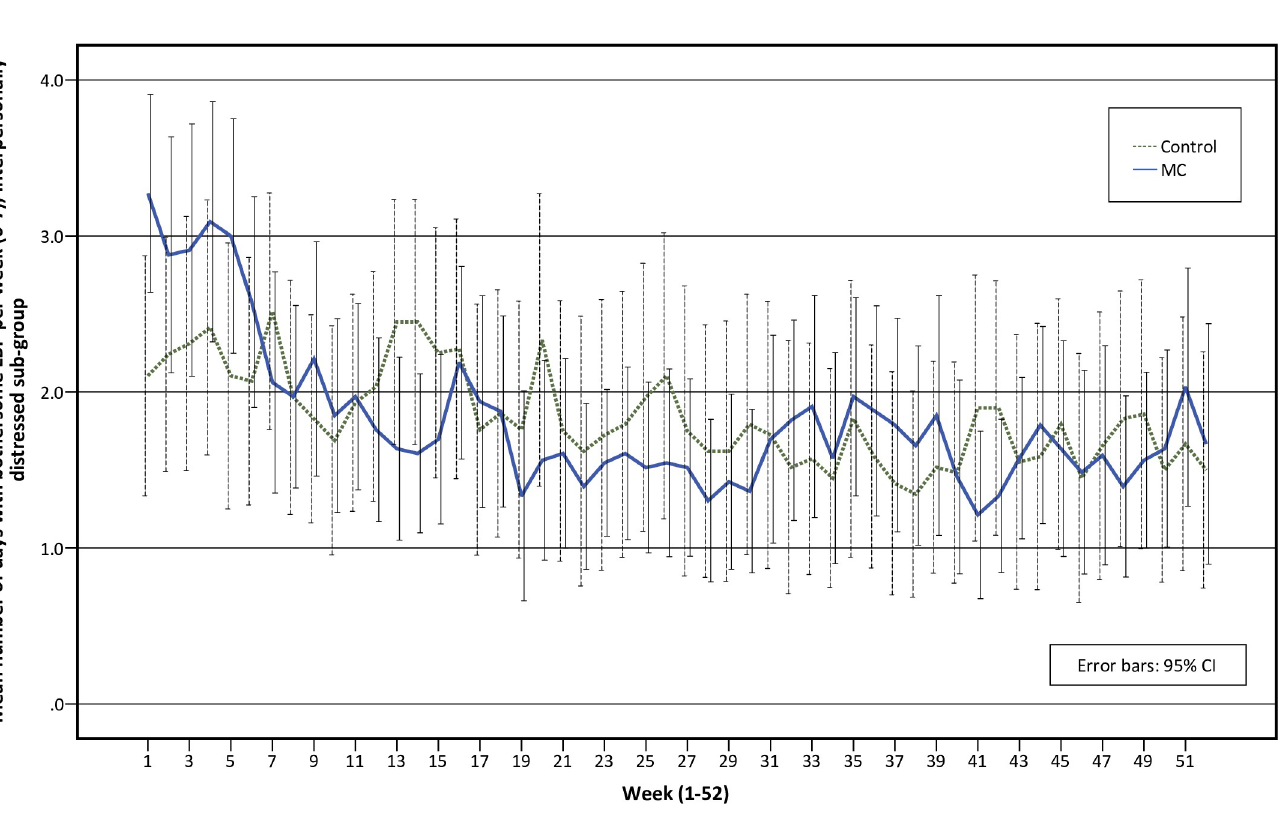
Fig 4. Pain trajectories for treatment groups in the interpersonally distressed sub-group.